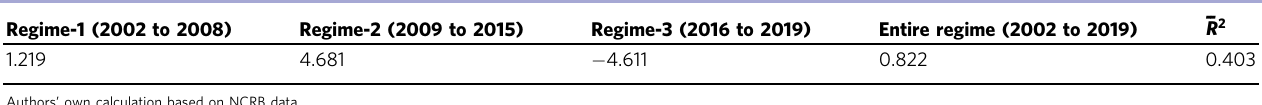
Table 4 Growth rate of incidents of sexual offences against children in India.